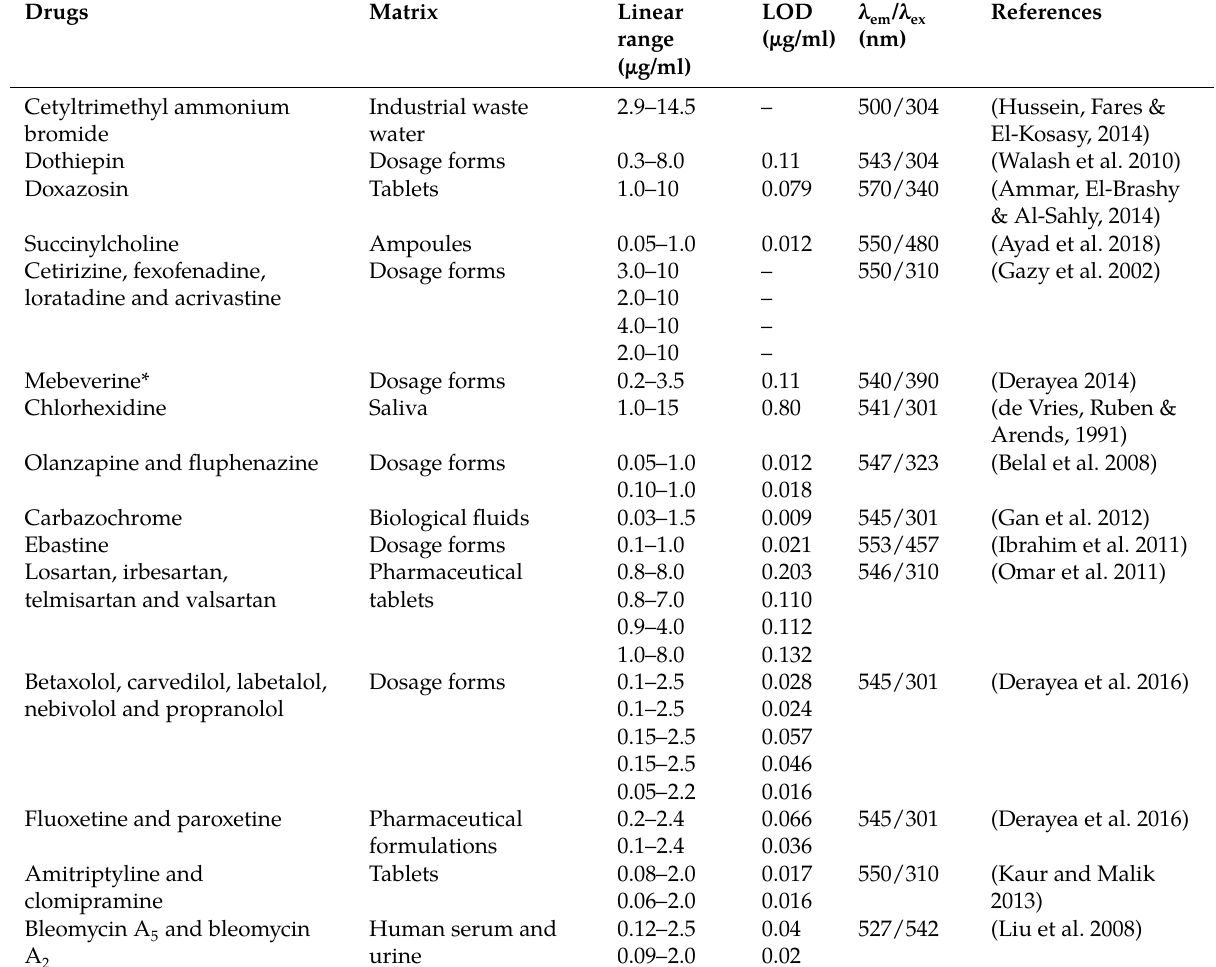
Table 4: Reported fluorescence quenching methods for pharmaceutical analysis based on binary complex formation with eosin